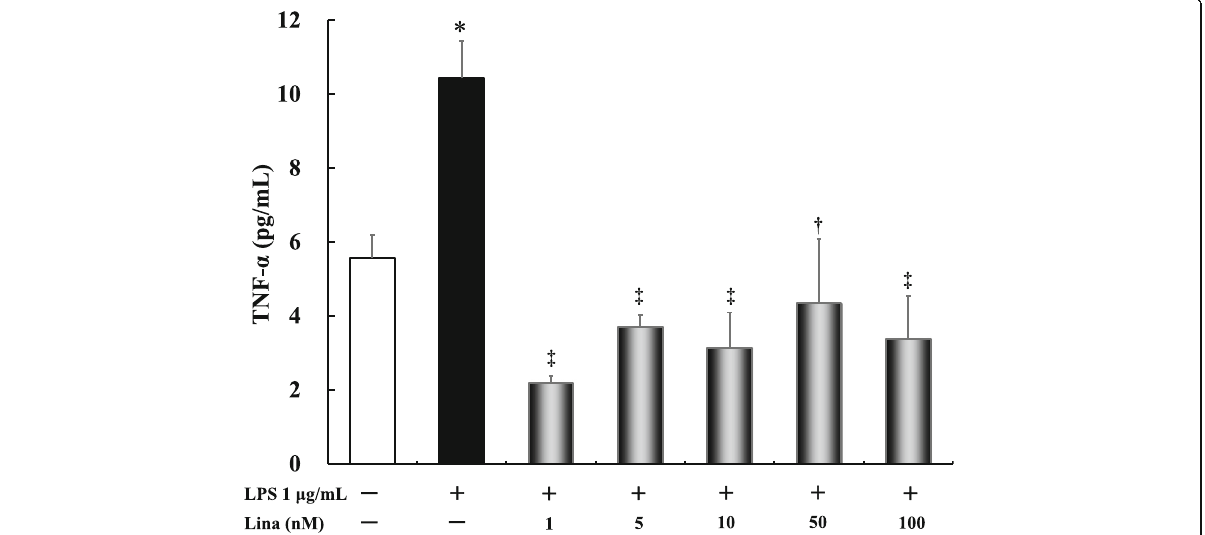
Fig. 3 Effects of linagliptin treatment on LPS-induced tumor necrosis factor (TNF)- α production after 24 h. Human U937 monocytes were treated with LPS and/or linagliptin. TNF- α levels in the supernatants were determined via ELISA after 24 h of treatment. * P < 0.001 vs. control; † P < 0.01 vs. LPS 1 μ g/mL; ‡ P < 0.0001 vs. LPS 1 μ g/mL. Lina,